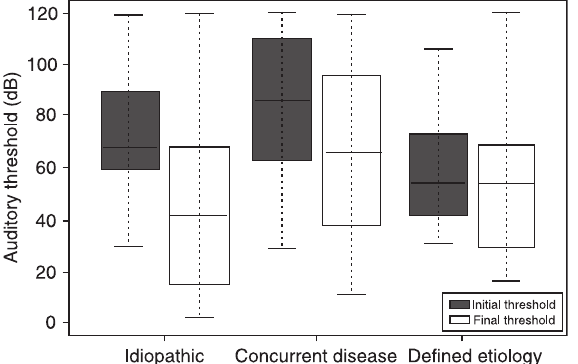
Figure 1. Mean initial and final auditory thresholds of the three